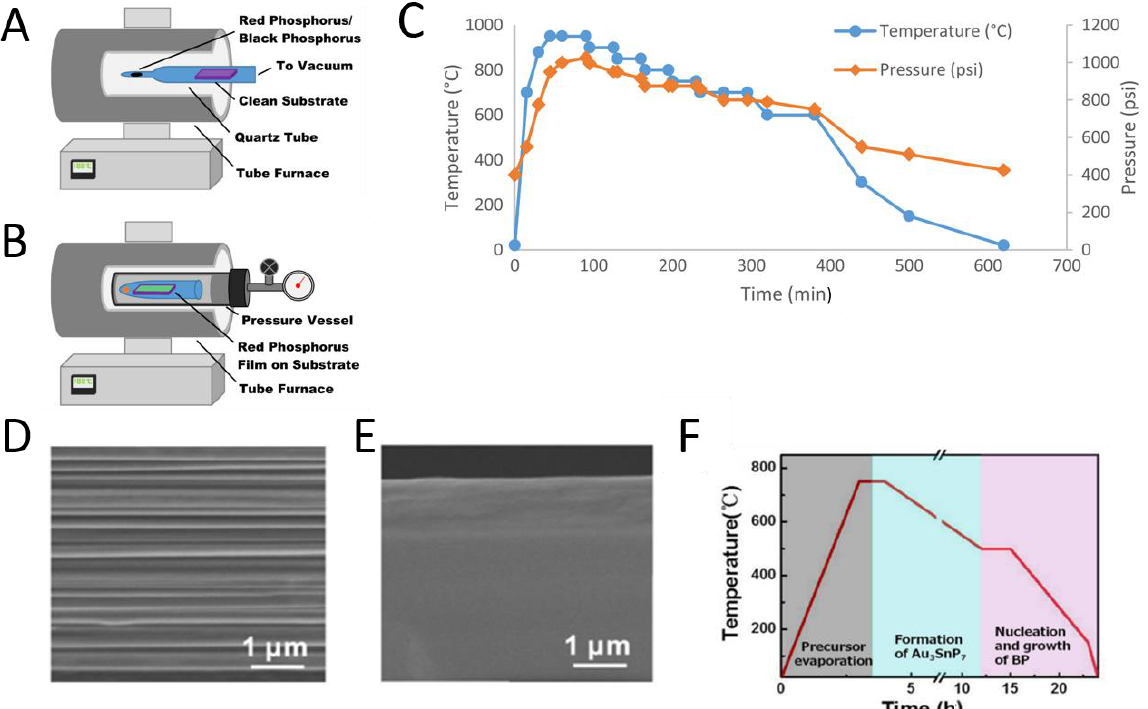
Figure 2. Synthesis of 2D BP nanosheets by the CVD method: ( A ) Schematic of amorphous red phos- phorus thin film growth from vapor deposition of red phosphorus powder/BP piece; ( B ) Standard temperature/pressure ramp for growth of substrate BP (SBP) from the red phosphorus thin films.